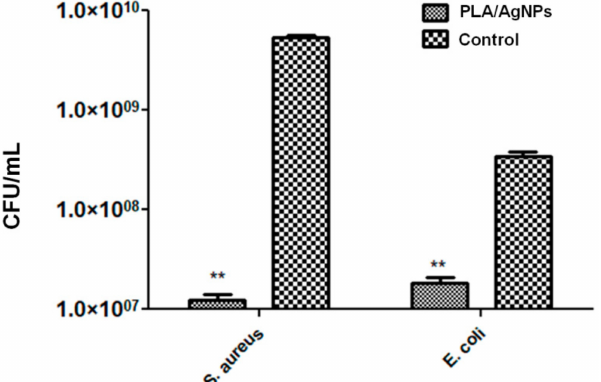
Figure 8. Microbial biofilm development of S. aureus (left) and E. coli (right) strains after 24 h of incubation with composite PLA / AgNPs